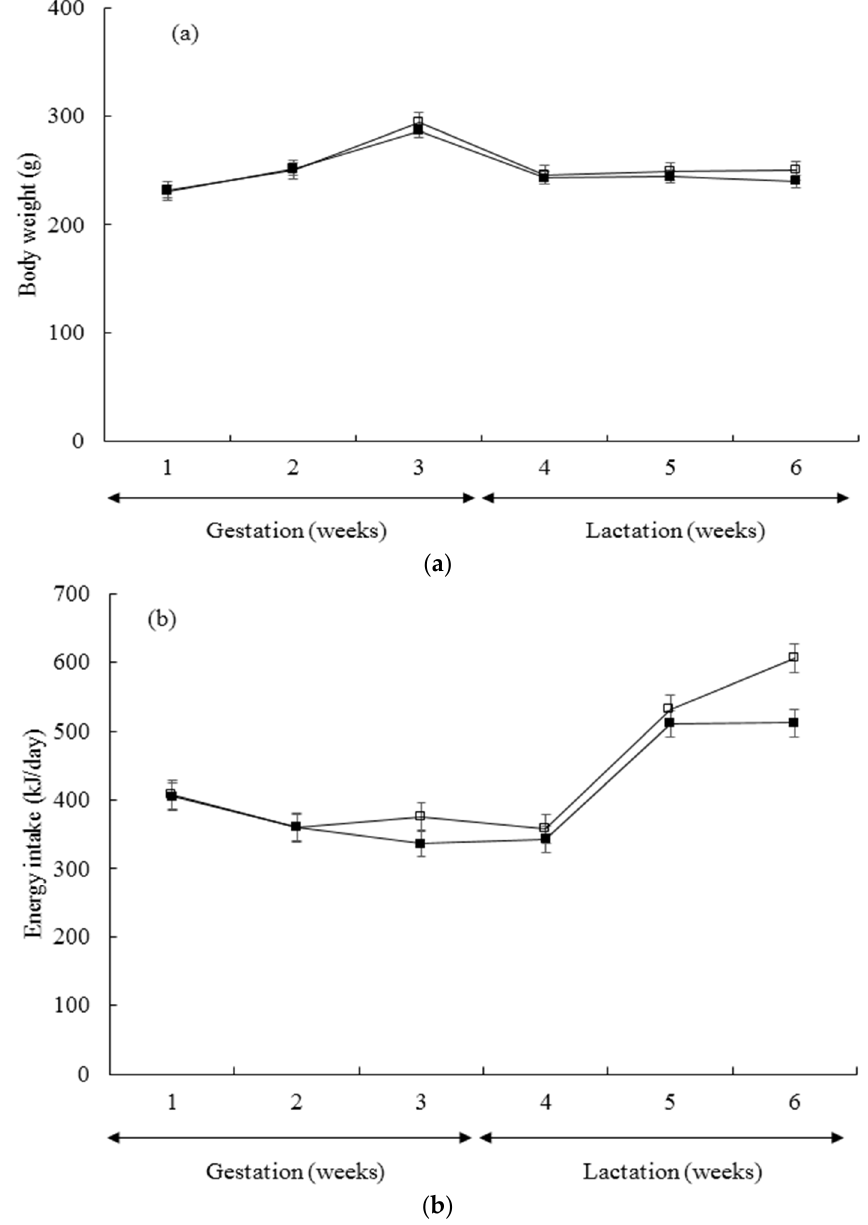
Figure 2. Cont. Figure 2.